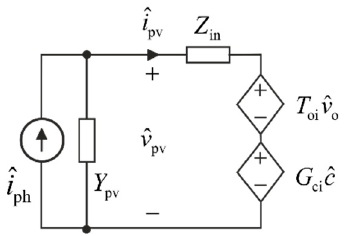
Figure 5. The interface between the PVG and its interfacing converter.